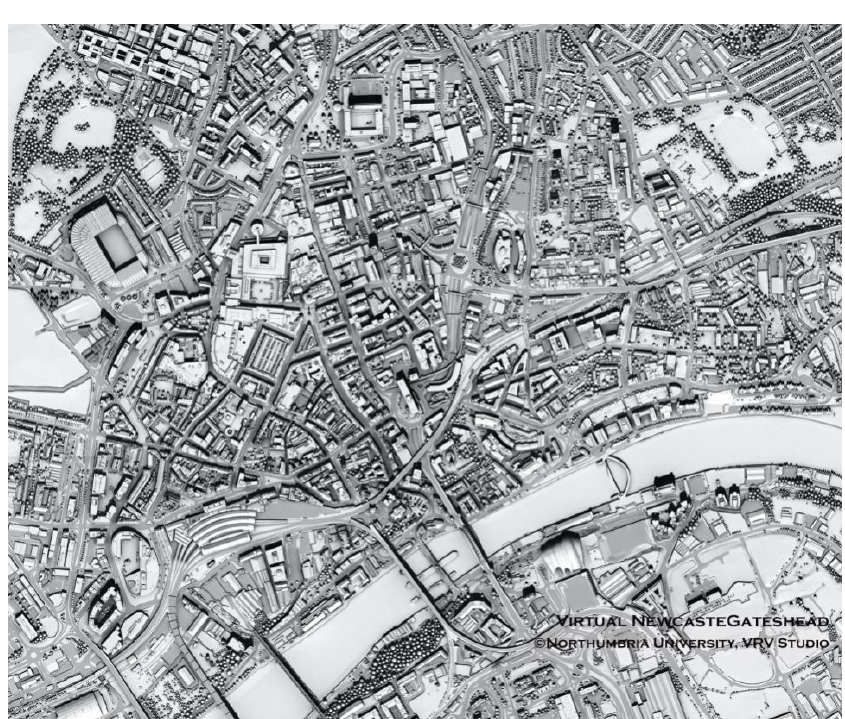
Figure 3. Potential occupier preference in Leeds.